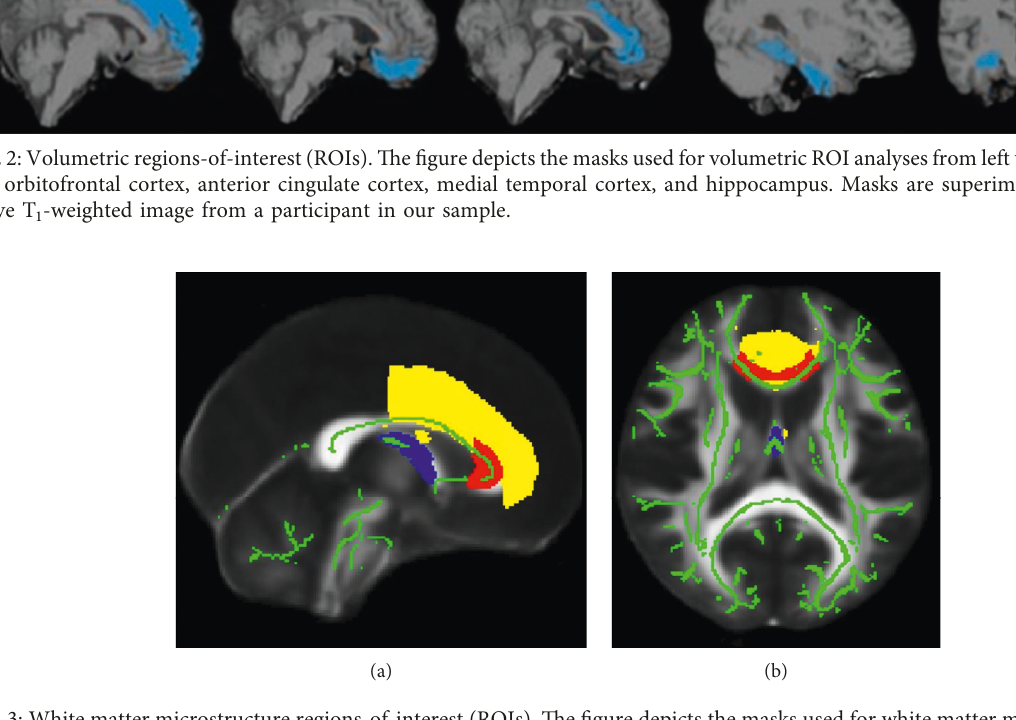
Figure 3: White matter microstructure regions-of-interest (ROIs). The figure depicts the masks used for white matter microstructure ROI analyses for the genu (red), fornix (blue), and anterior cingulum (yellow) in the sagittal view (a) and axial view (b). Masks are superimposed on a single-subject diffusion-weighted template in MNI space provided by Johns Hopkins University (JHU) in FMRIB’s Software Library (FSL). The mean skeleton for the sample is overlaid on the diffusion-weighted image in bright